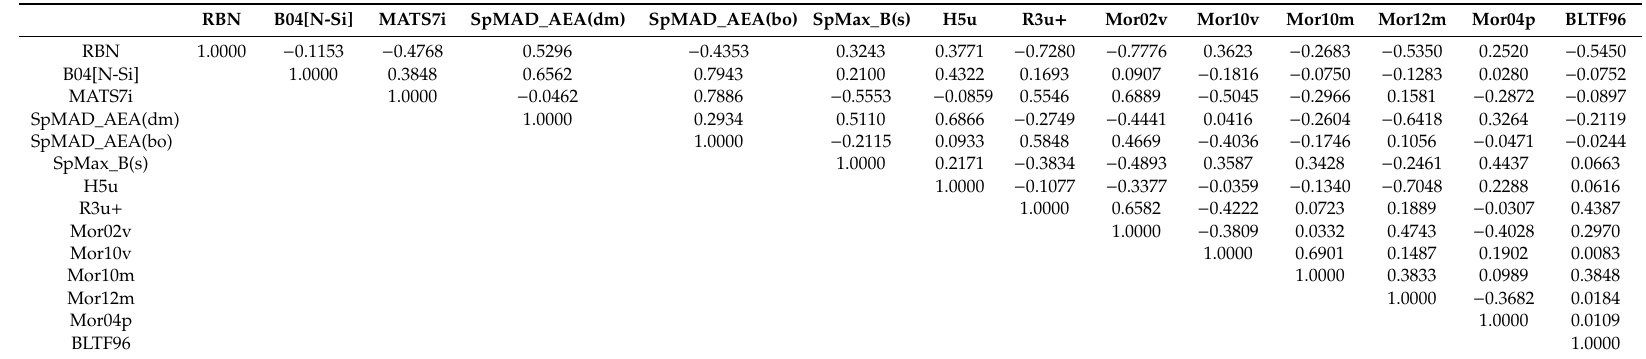
Table A3. Correlation matrix of the molecular descriptors representing the poly(siloxane) stationary